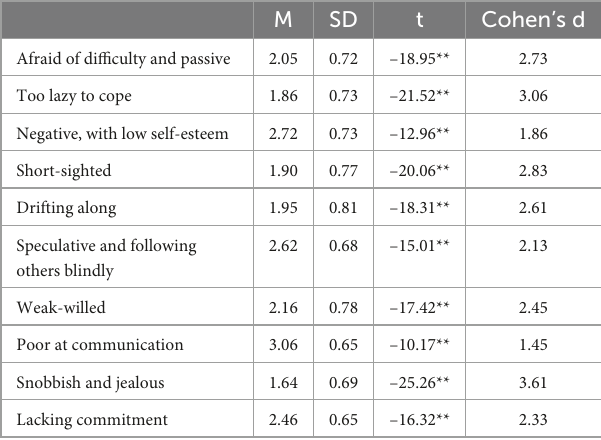
TABLE 1 Validity scores for negative